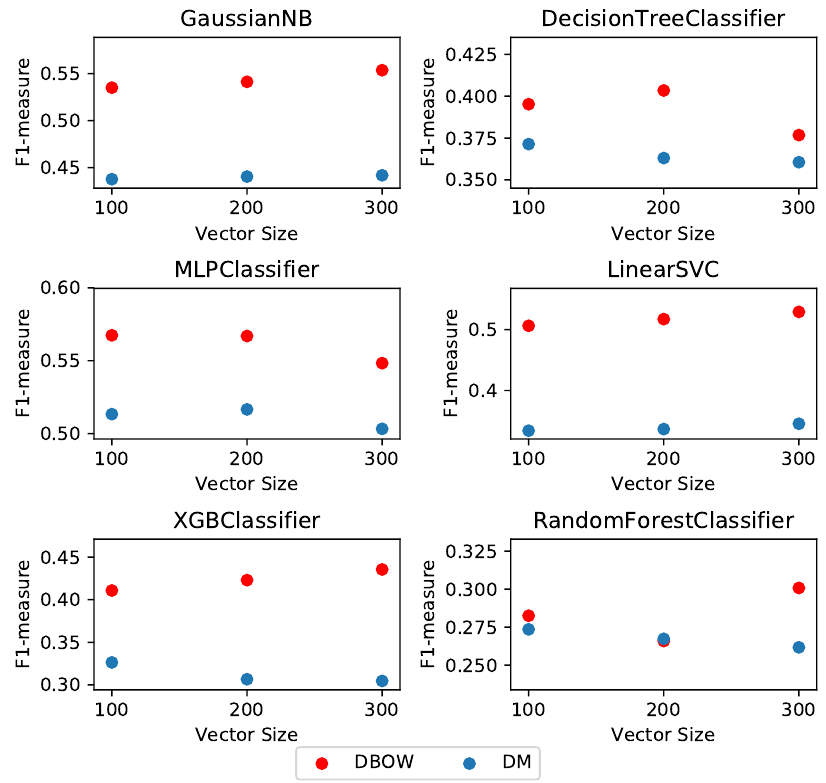
Figure 5. F1 scores using different dimensions for Doc2vec, using DBOW (in blue) and DM (in